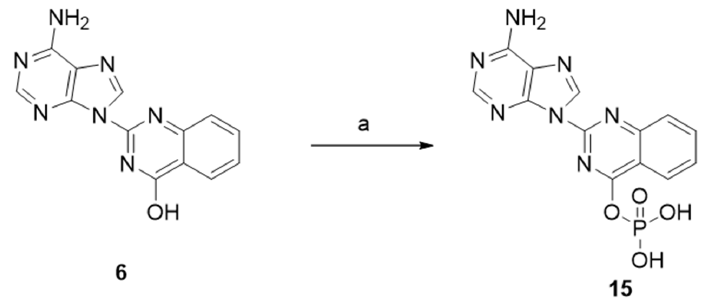
Figure 7. Phosphorylation of compound 6 . Reagents and conditions: (a) phosphorus pentachloride (P 2 O 5 ), tetrabutylammonium bromide (TBAB), hydrogen peroxide solution (30% H 2 O 2 ), CH 3 CN/H 2 O, 0 °C, 5 h.